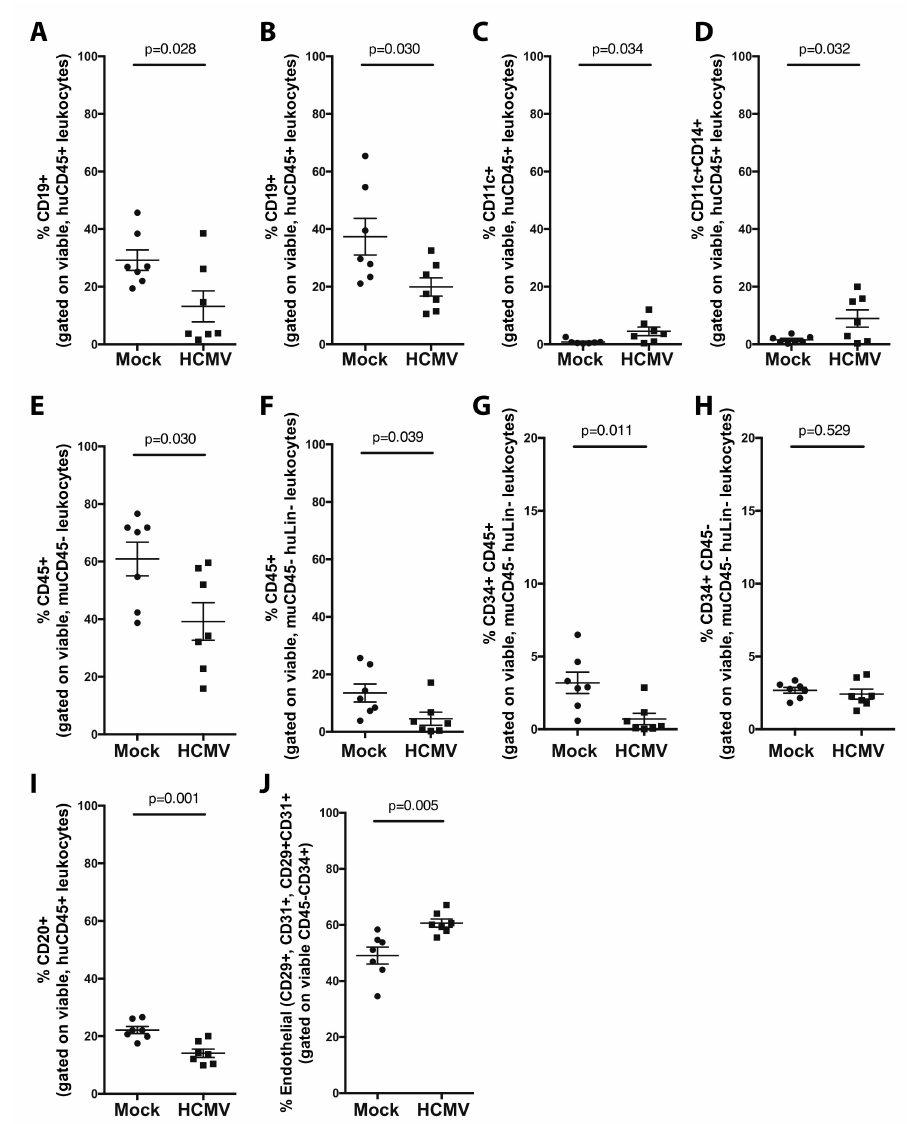
Figure 3. HCMV preferentially alters CD34 + HPC engraftment and di ff erentiation of myeloid and lymphoid populations in vivo in huBLT mice. huBLT mice were generated and infected with HCMV as described in Figure 1. Analysis of the mature lymphoid and myeloid populations in the periphery at 12 weeks post-humanization was performed by flow cytometry analysis of total viable muCD45 − leukocytes. Analysis of the mature, peripheral populations was performed by quantification of CD19 + B-cells (gated on huCD45 + leukocytes) in the blood ( A ) and spleen ( B ); and CD11c + dendritic cells ( C ) or CD11c + CD14 + bulk monocytic cells ( D ) (gated on huCD45 + viable leukocytes) in the spleen. Analysis of engraftment success and stem cell maturation was performed on total bone marrow flushed from the femur by quantification of the following: total human leukocytes (gated on huCD45 + , muCD45 − , viable leukocytes) ( E ), bulk hematopoietic progenitors (gated on huCD45 + , muCD45 − , huLin-, viable leukocytes) ( F ), CD34 + lymphoid and myeloid progenitor cells (gated on huCD45 + , muCD45 − , huLin - , viable leukocytes) ( G ); and CD34 + HPCs (gated on huCD45 − , muCD45 − , huLin - , viable leukocytes) ( H ). Quantification of specific cell populations in the bone marrow: total CD20 + B-cells (gated on huCD45 + viable leukocytes) ( I ) and total hemato-endothelial progenitors (gated on huCD29 + and / or huCD31 + , huCD45 − , huCD34 + viable leukocytes) ( J ). All data show standard error of the mean for 7 individual mice per group. Significance was determined by unpaired t-test, and p - values are